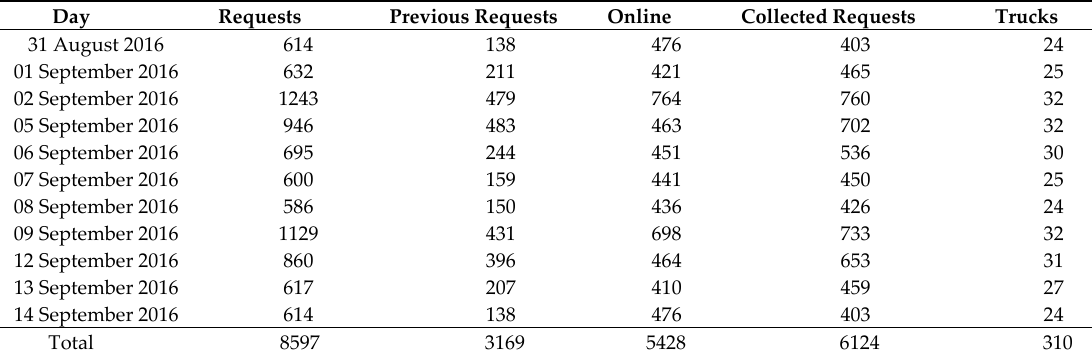
Table A3. Results obtained with Minimum -k